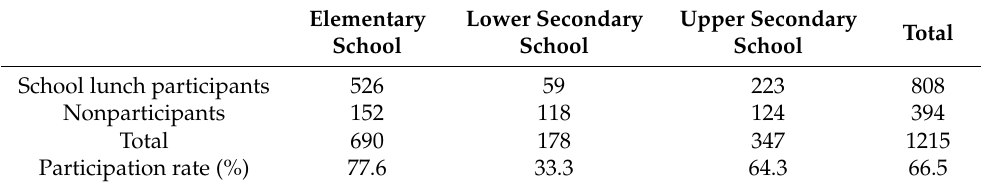
Table 4. Proportion of students participating in school lunch, stratified by school type.